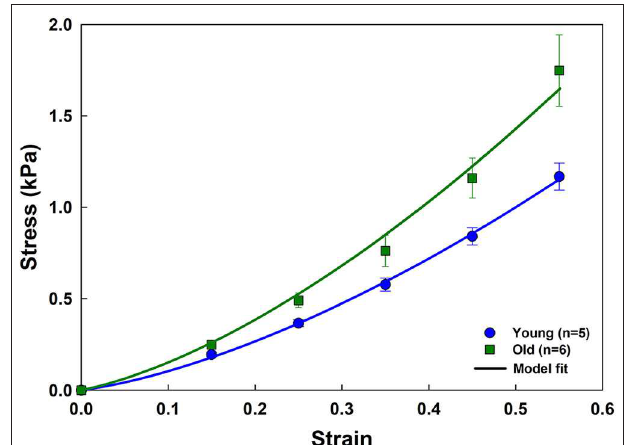
FIGURE 7 | Stress-strain curves and parameter estimation results for the aging data. Experimental data (mean and standard errors) for young and old mice are shown with symbols. Model fits are plotted as solid